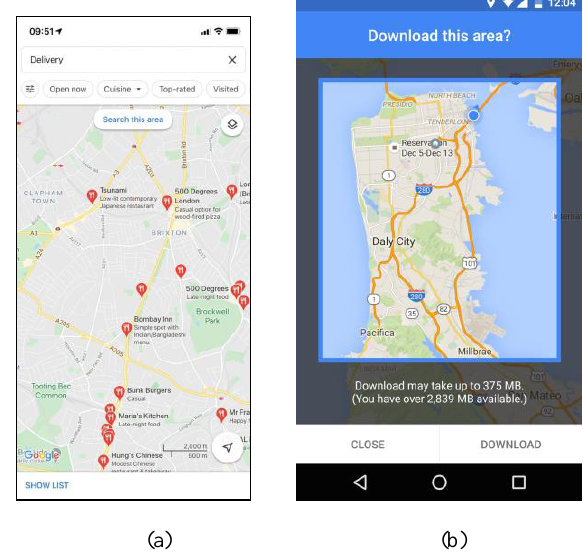
Figure 9. (a) Querying takeaway restaurants on Google Maps (b) Downloading offline maps on Google Maps